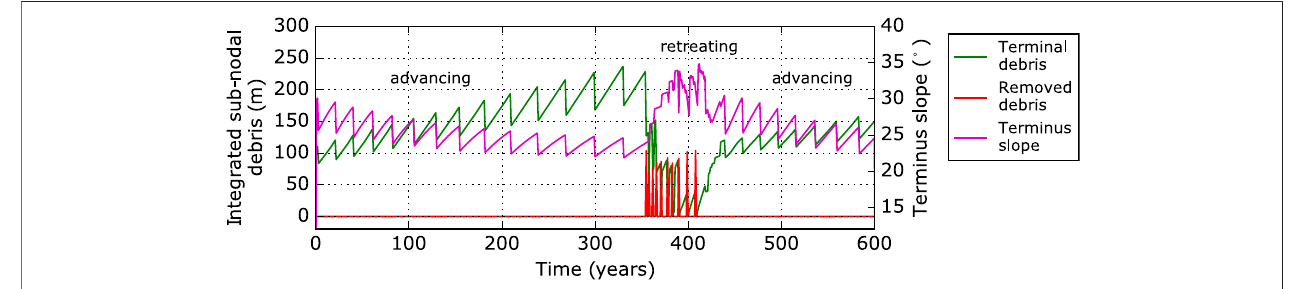
FIGURE9| Evolutionofdebriscoverageandslopeoftheterminusincaseofdeterministicdebrisdisplacementandremovalfor C (cid:1) 0.20.Terminaldebrisisthesum of sub-nodal debris loads across the last fi ve nodes (green). Removed debris is calculated from sub-nodal values as well (red). Terminus slope is calculated considering the last fi ve nodes (magenta). Note that the last fi ve nodes migrate in fl ow direction in case of an advancing glacier. Just after advancing to the next node, the last glacier node has very low debris cover and surface elevation. This bias is responsible for the observed saw tooth behavior.